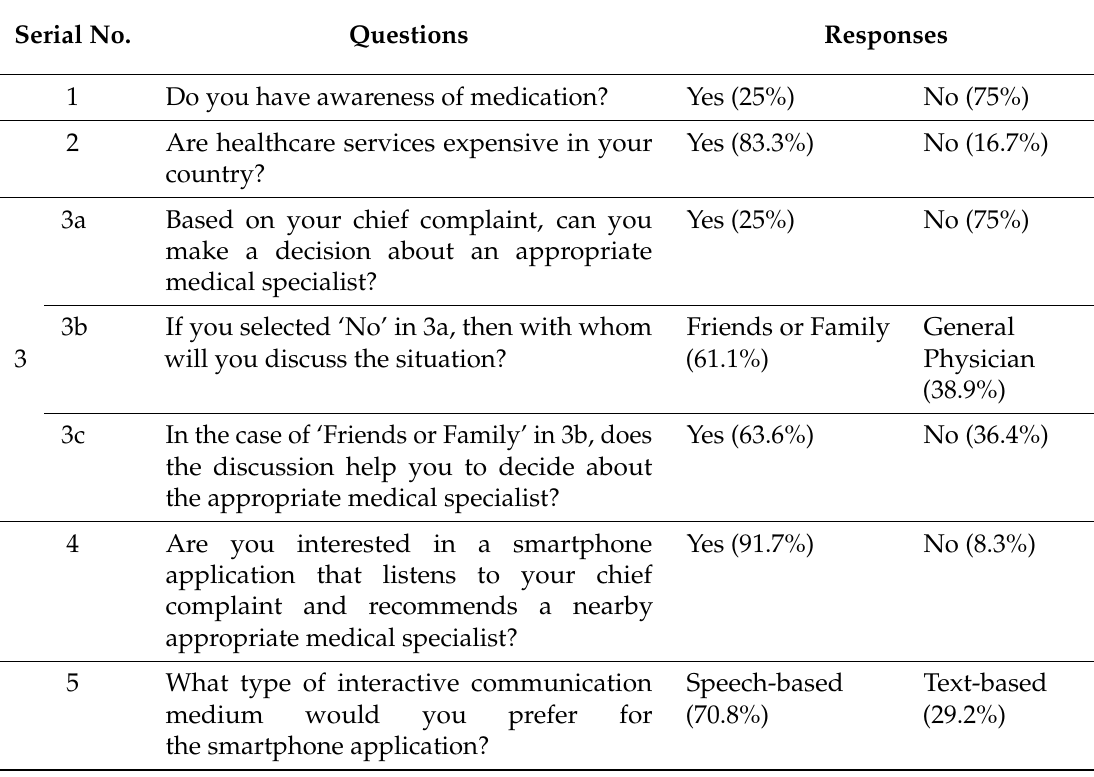
Figure 1. Medical awareness survey: Country-based distribution of participants along with gender ratio. Table 1. Medical awareness survey questionnaire